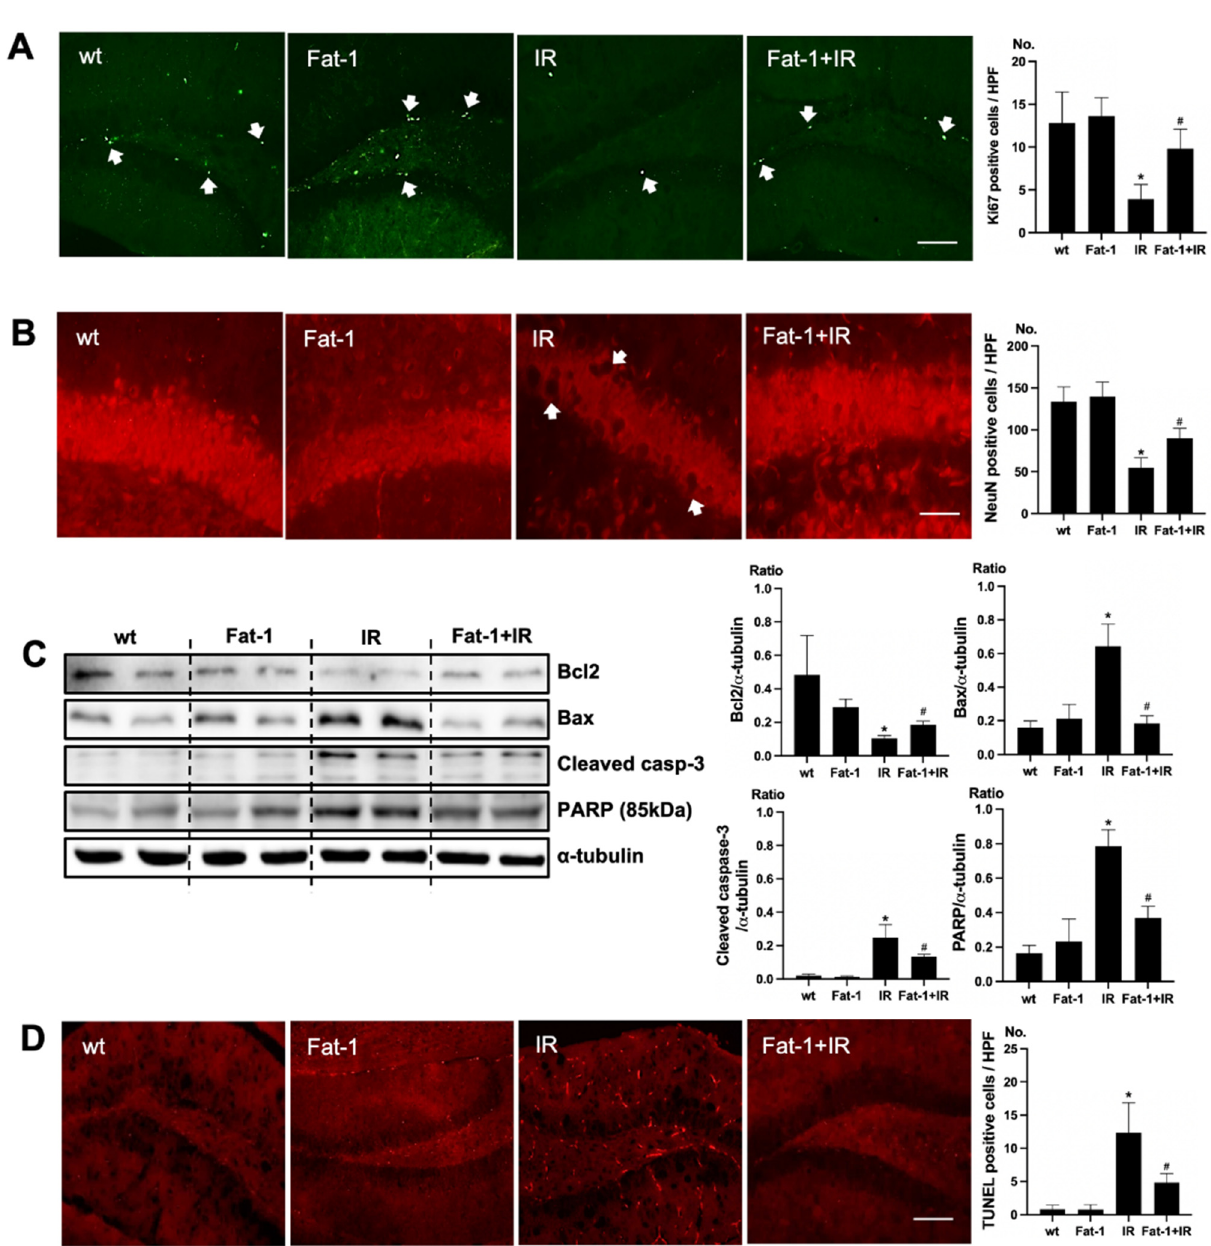
Figure 4. Effects of ω -3 PUFA on brain damage in ischemia-reperfusion (IR) injured Fat-1 mice. ( A ) Representative immunofluorescence stain of the subgranular zone of the hippocampal DG of the brain section: Immunofluorescent staining was performed using Ki67 in the brain. High power field (HPF), original magnification, 200 × . Scale bar = 50 µ m. ( B ) Repre- sentative immunofluorescence stain of the subgranular zone of the hippocampal DG of the brain section: Immunofluorescent staining was performed using NeuN in the brain. Original magnification, 400 × . Scale bar = 200 µ m. ( C ) Representative Western blot of brain lysis: The brain of uremic Fat-1 mice shows decreased Bax, cleaved caspase3 expression, and increased Bcl2 expression compared to the brain of uremic mice. Additionally, PARP (85 kDa) expression was also reduced in the brain of uremic Fat-1 mice compared to the brain of uremic mice. ( D ) Representative TUNEL stain of the subgranular zone of the hippocampal DG of the brain section. Original magnification, 200 × . Scale bar = 50 µ m. * p < 0.001 vs. wt, # p < 0.001 vs. IR. Bar represents mean ± S.D. (wt, wild-type sham; Fat-1, Fat-1 induction sham; IR, IR renal injury in wild-type mice; Fat-1+IR, IR renal injury in Fat-1 induction